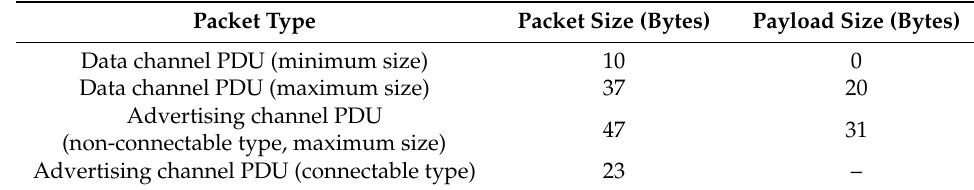
Table 3. Packet and payload sizes considered in the evaluation. For a maximum sized data channel PDU, the maximum payload size is 20 bytes of attribute notification. The maximum payload allowed in the non-connectable advertisement type (used in the advertisement-based approach) is 31